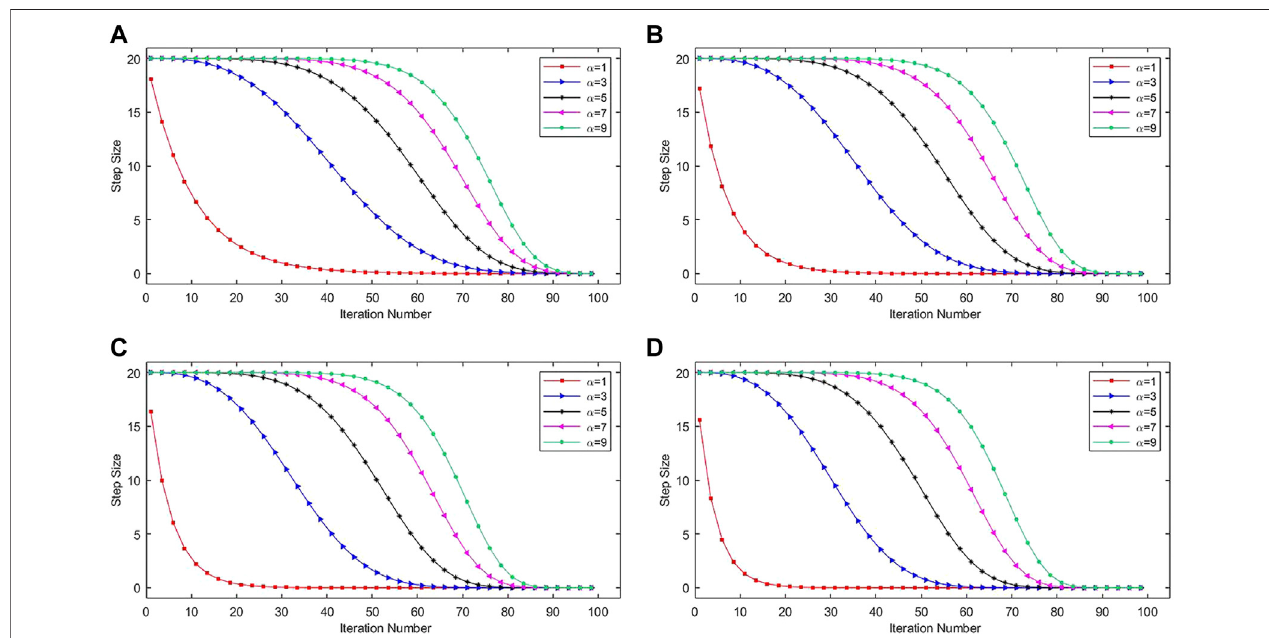
FIGURE 1 | Multivariate adaptive step size corresponding to different values of N and α : (A) N = 10, (B) N = 15, (C) N = 20, and (D) N = 25.